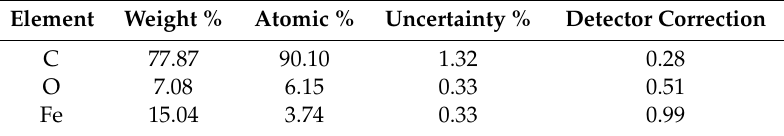
Table 2. Elemental analysis of synthesized iron oxide nanoparticles.